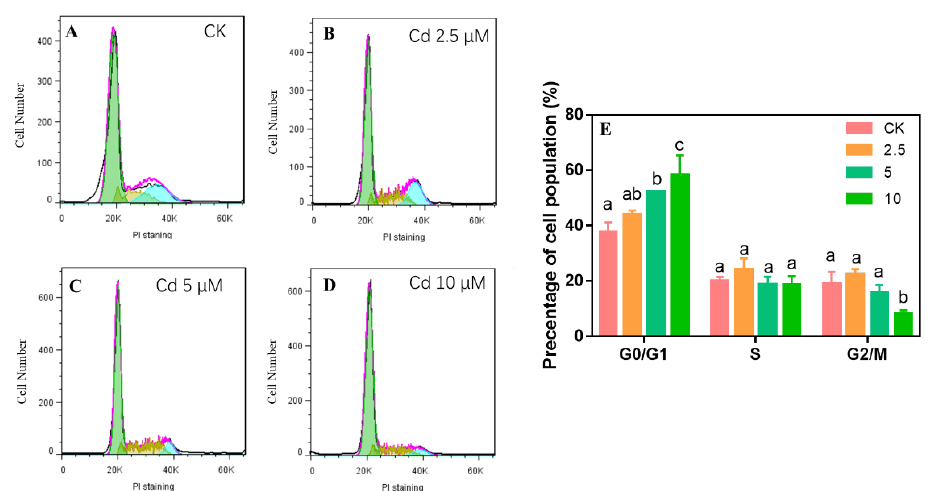
Figure 4. HaCaT cell cycle arrest was induced by exposure to 2.5–10 µ M Cd for 24 h ( A – E ). Flow cytometry results showing that cells were arrested in G0/G1 phase ( A – D ) and the histogram of cell cycle distribution ( E ). Different letters in the same phase indicate significant differences at p < 0.05.